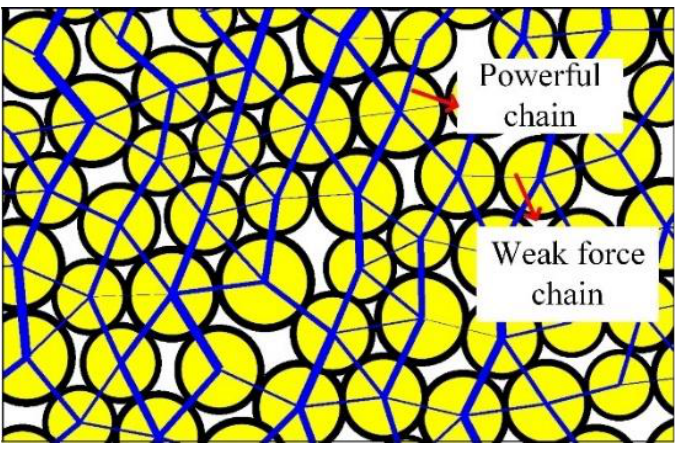
Figure 21. Regional force chain. When the coal seam is not mined, the rock layer is in a stable stress balance state, the force chain is in a crisscross network state, the contact form is closed, and the strong and weak force chains jointly bear the load of the overlying rock layer. After the coal seam mining, the stress balance is broken, and the external force promotes the redistribution of the force chain. The strong chain changes with the advancing direction of the working face. The main direction of the force chain indicates the direction and path of load